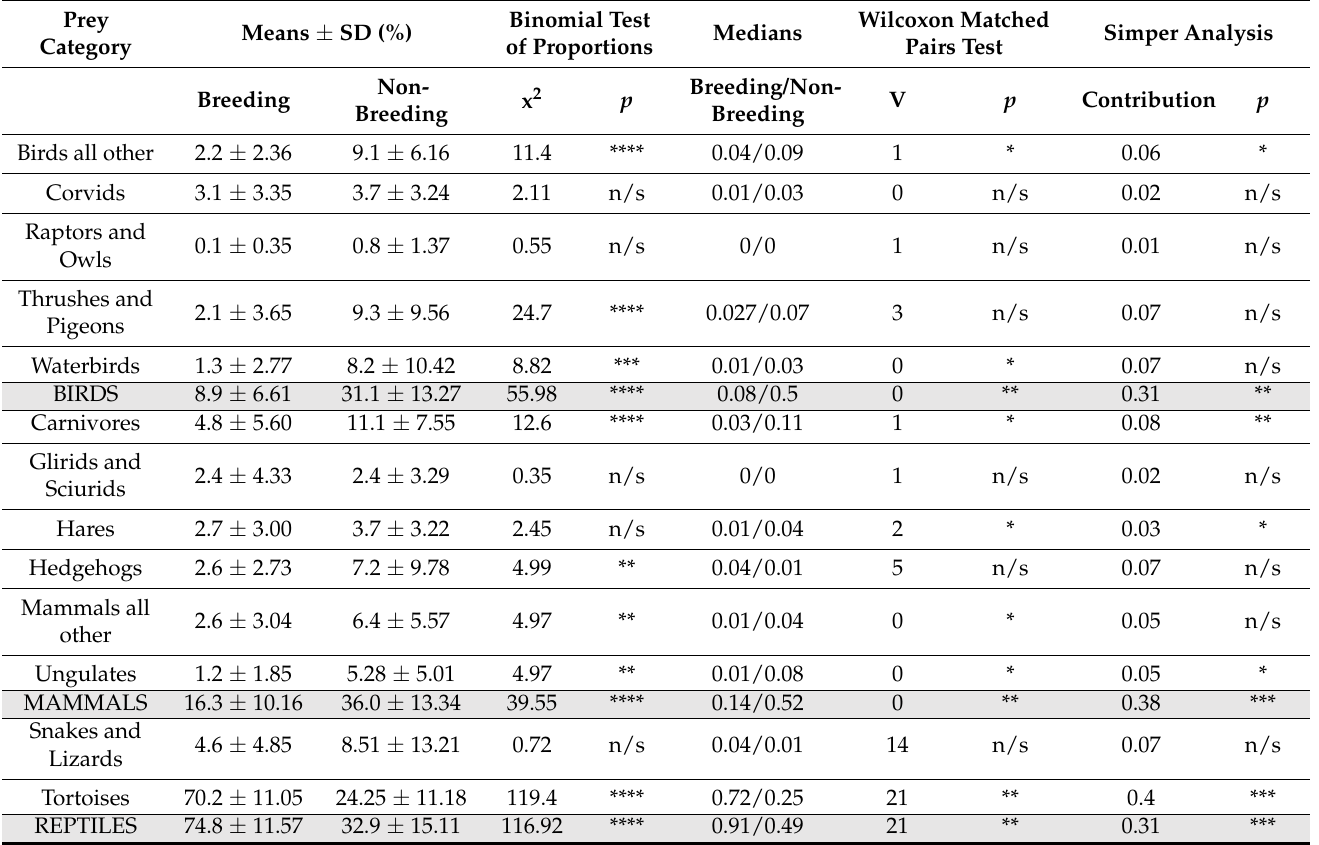
Table 2. Seasonal variation of golden eagle diet in terms of Wilcoxon matched pairs test and Simper Analysis (n territories = 6, where the number of prey items was ≥ 10). Means and Binomial test of proportions considered 11 breeding territories and 7 non-breeding territories. Mean values refer to